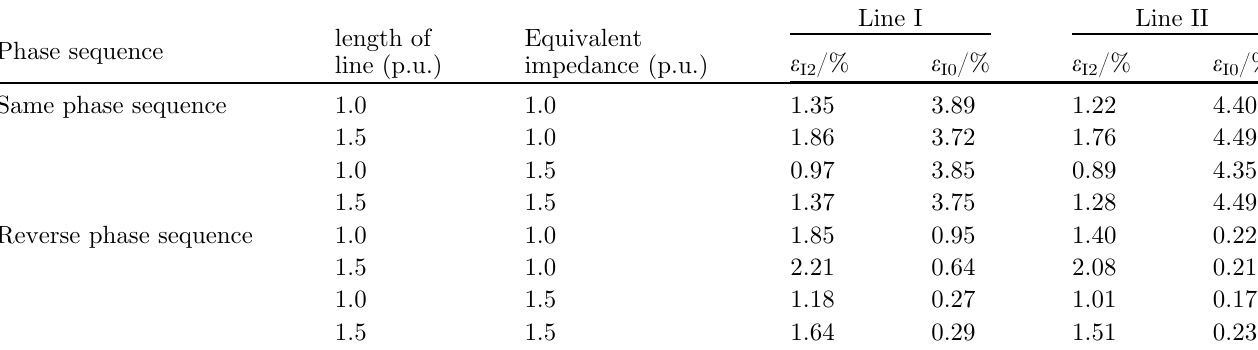
Table 7. In fl uence of line length and equivalent impedance on current unbalance. Phase